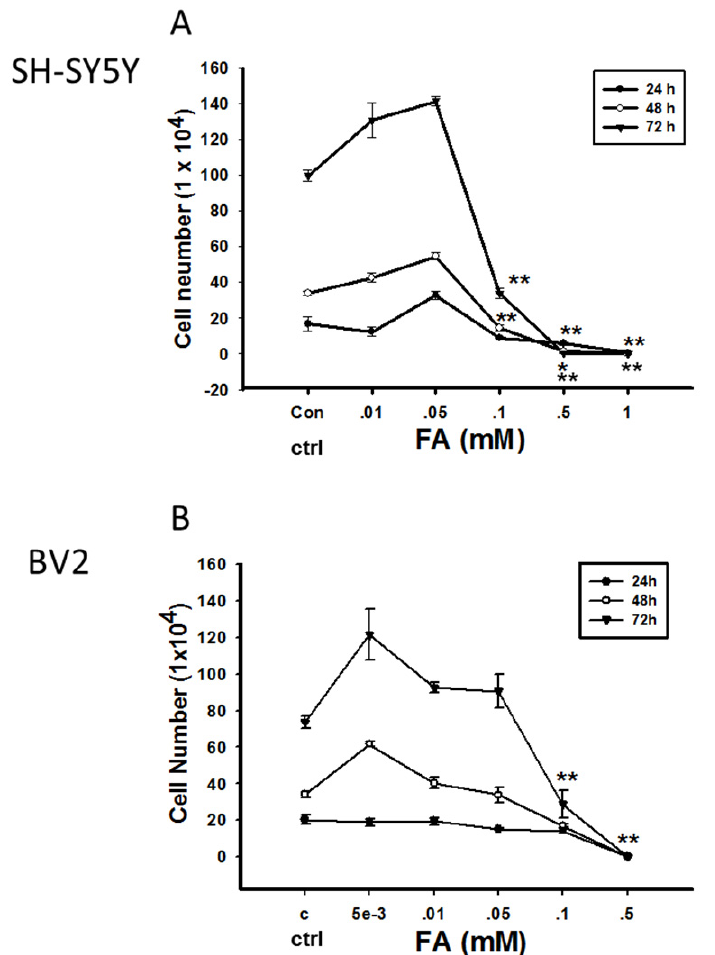
Figure 1. Effect of exogenous formaldehyde (FA) on the viability of SH-SY5Y cells and BV2 cells. SH-SY5Y cells and BV-2 cells were cultured with different concentrations of FA in Dulbecco’s Modified Eagle Medium containing 10% fetal calf serum (37 ◦ C, 5% CO 2 ). The viability of cells was assayed using the CCK8 assay at different time points. Cell viability of SH-SY5Y ( A ) and BV-2 cells ( B ) is shown, respectively. Cells without FA treatment were used as control ( n = 3; means ± S.E.M; * p < 0.05, ** p < 0.01).